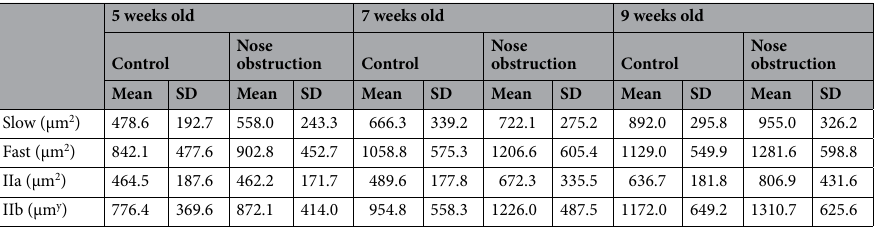
5 weeks old 7 weeks old 9 weeks